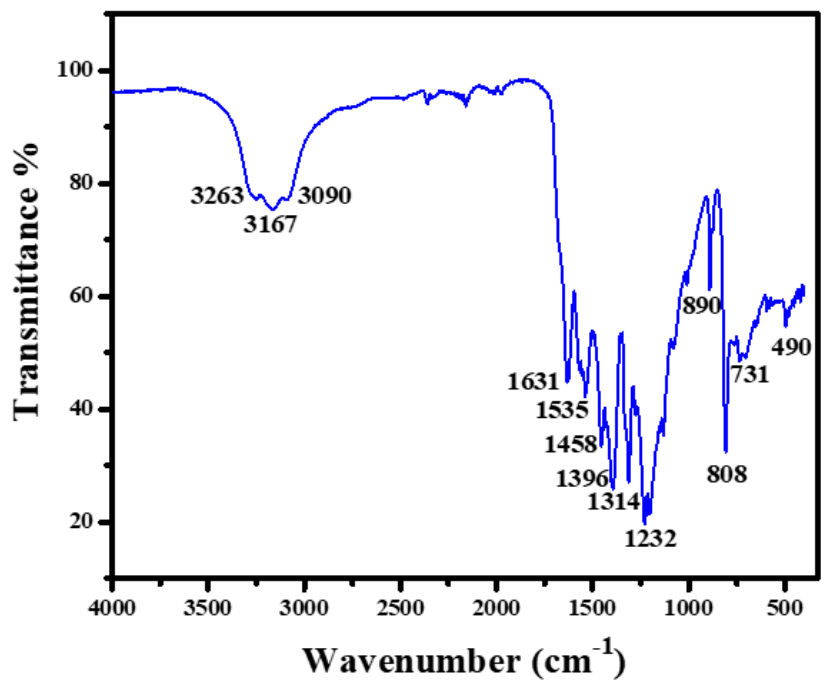
Figure 2. FTIR of Ru-ZnO − g − C 3 N 4 nanosorbent.